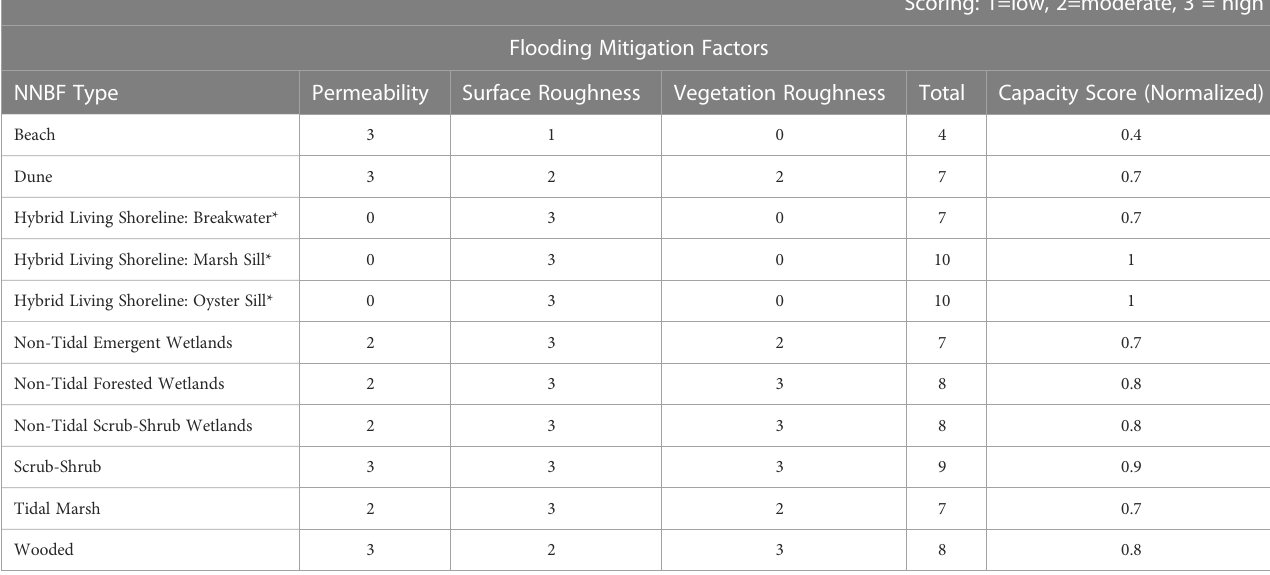
Scoring: 1=low, 2=moderate, 3 =